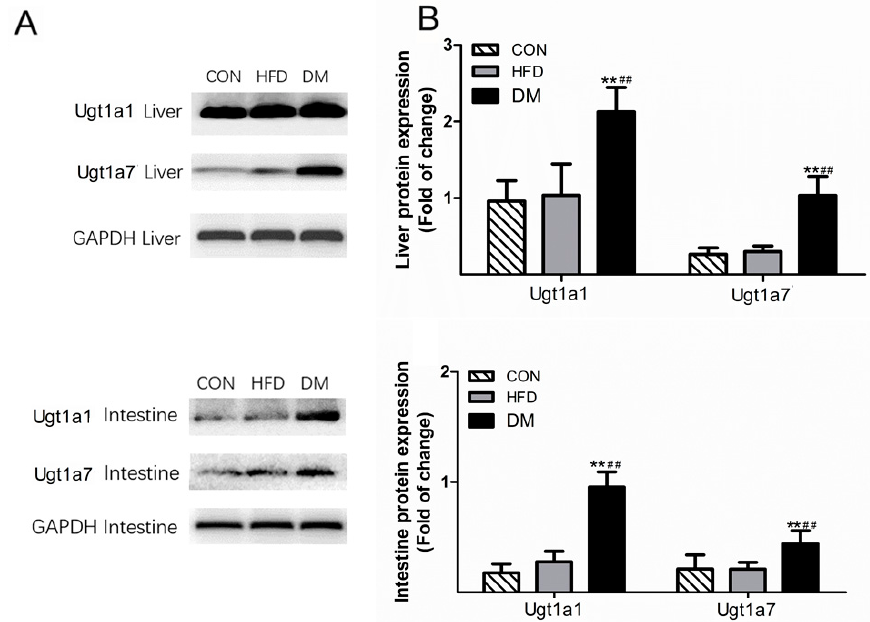
Figure 5. Expression of hepatic and intestinal uridine diphosphate (UDP)-glucuronosyltransferase (UGT) 1A1 ( Ugt1a1 ) and Ugt1a7 proteins in DM, HFD, and CON rats. Data represent the mean ± SD, n = 3 rats, * p < 0.05, ** p < 0.01 in DM versus CON rats; # p < 0.05, ## p < 0.01 in DM versus HFD rats.